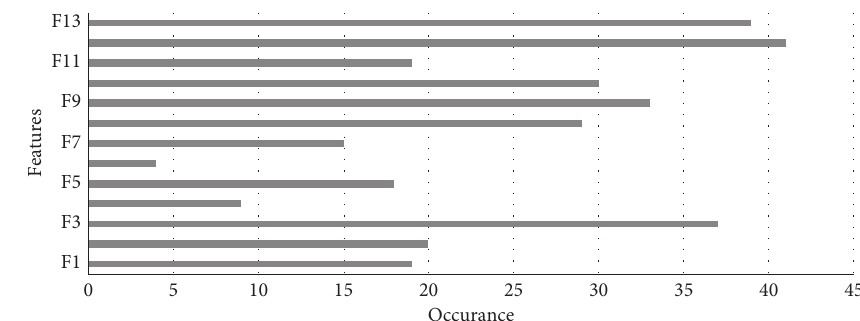
Figure 3: Summary of features selected by feature selection